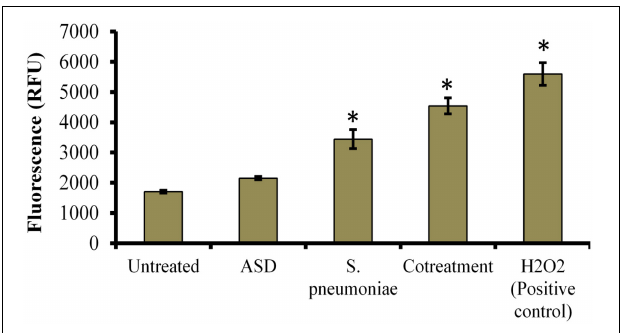
FIGURE 6 | Reactive oxygen species (ROS) production in HMEECs treated with S. pneumoniae or ASD or co-treatment. The error bars represent the standard deviation from the mean, and statistical significance was calculated by one-way ANOVA. ∗ P -value less than 0.05 was considered significant.